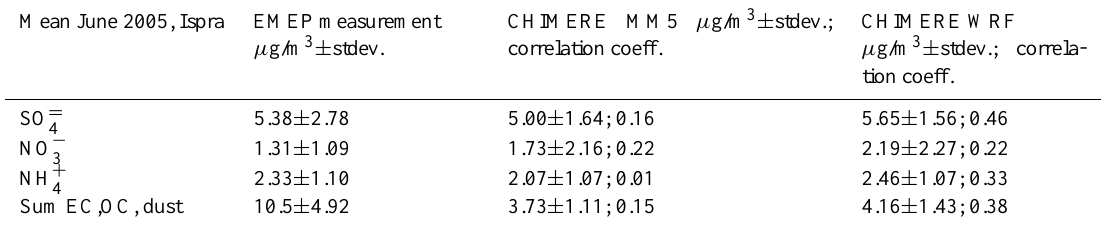
Table 7. Monthly mean measured concentrations for Ispra of SO = , NO − and NH + , together with the model calculated mean concentrations 4 3 4 using MM5 and WRF, for June 2005, including the standard deviation and the temporal correlation coefficient. Mean June 2005, Ispra µ g/m 3 ±